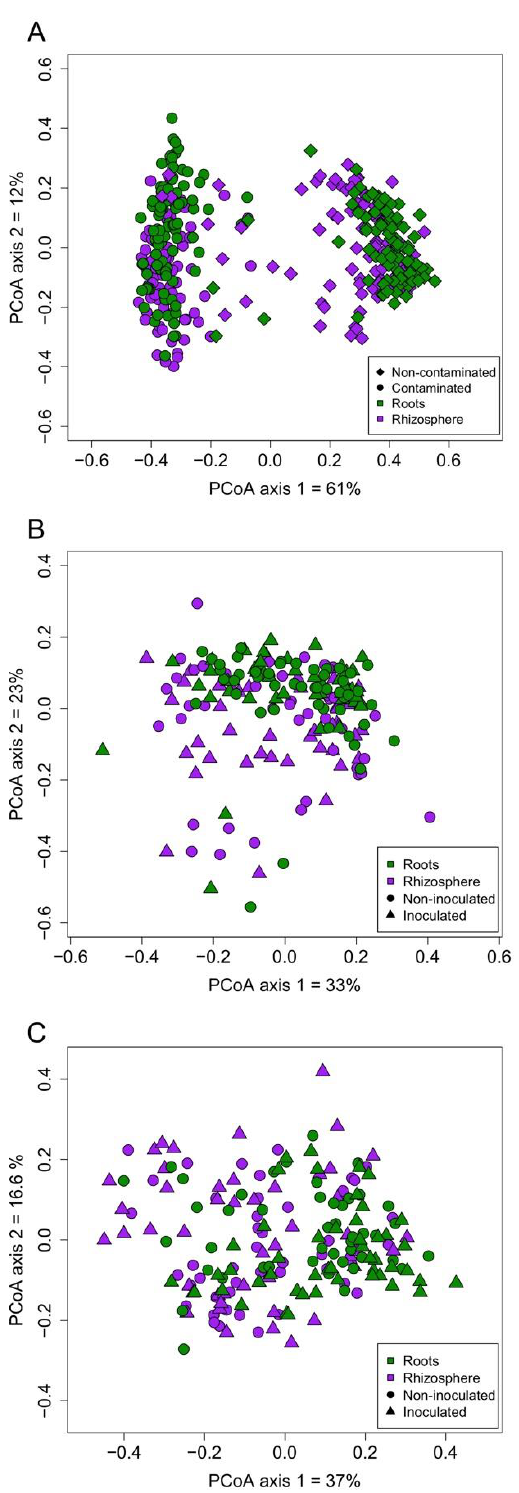
Figure 2. Principal coordinate analysis based on the Bray–Curtis dissimilarity of ( A ) roots and rhizosphere AMF communities together from both type of substrates (non-contaminated soil or contaminated sediments), and separately from ( B ) the non-contaminated soil and ( C ) the contaminated sediments.